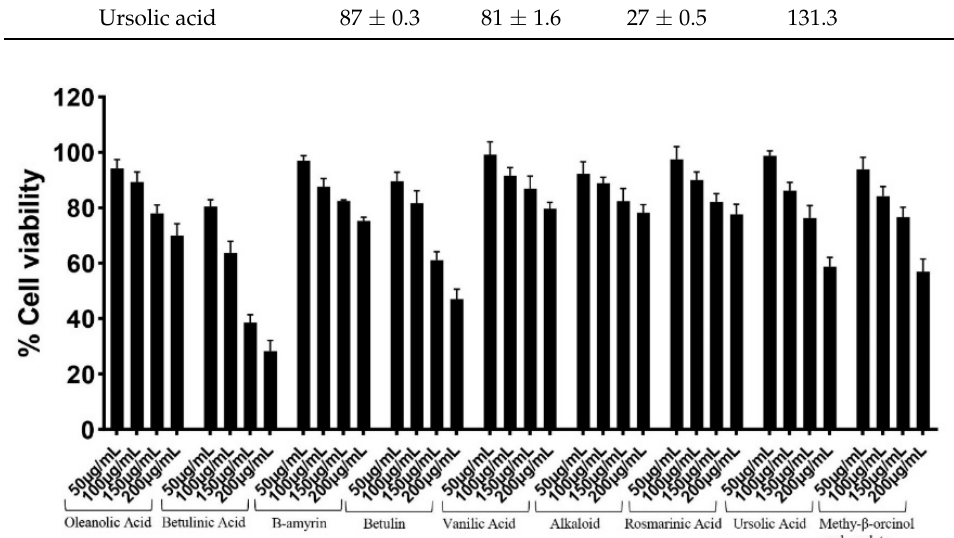
Figure 2. The plant-based compounds exhibited minimal cytotoxic activity against human cell lines. Confluent monolayers of HeLa cells were challenged with 50 µ g/mL, 100 µ g/mL, 150 µ g/mL, and 200 µ g/mL of the plant-based compounds. All compounds were non-cytotoxic at a concentration of 100 µ g/mL except betulinic acid, as it exhibited weak cytotoxicity. Cell cytotoxicity below 20% is considered non-cytotoxic, while cell cytotoxicity between 20% to 40% is considered to have weak cytotoxicity. The data are illustrative of several independent experiments and presented as the mean ± standard error.